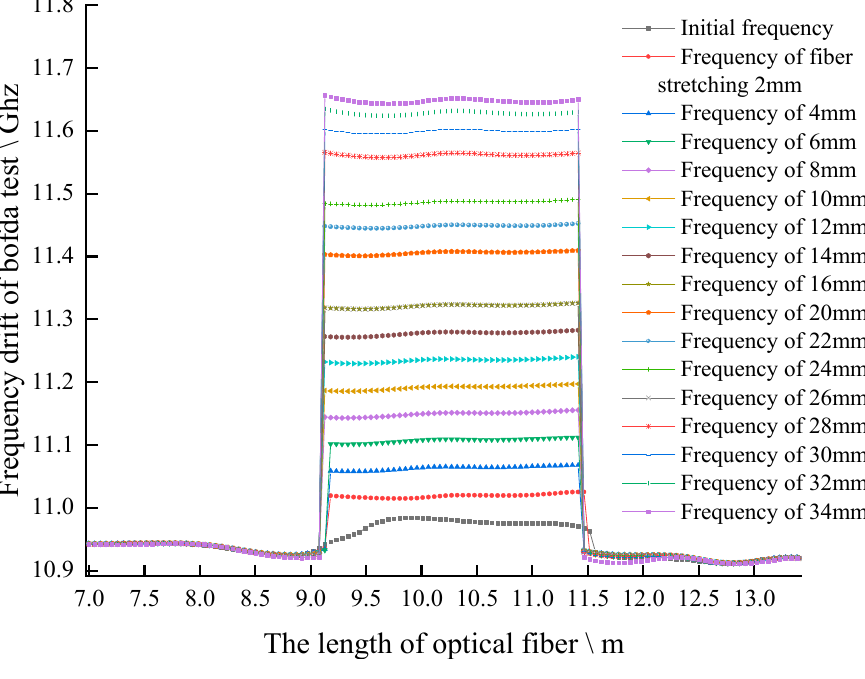
Figure 12. Original Brillouin frequency shift diagram.